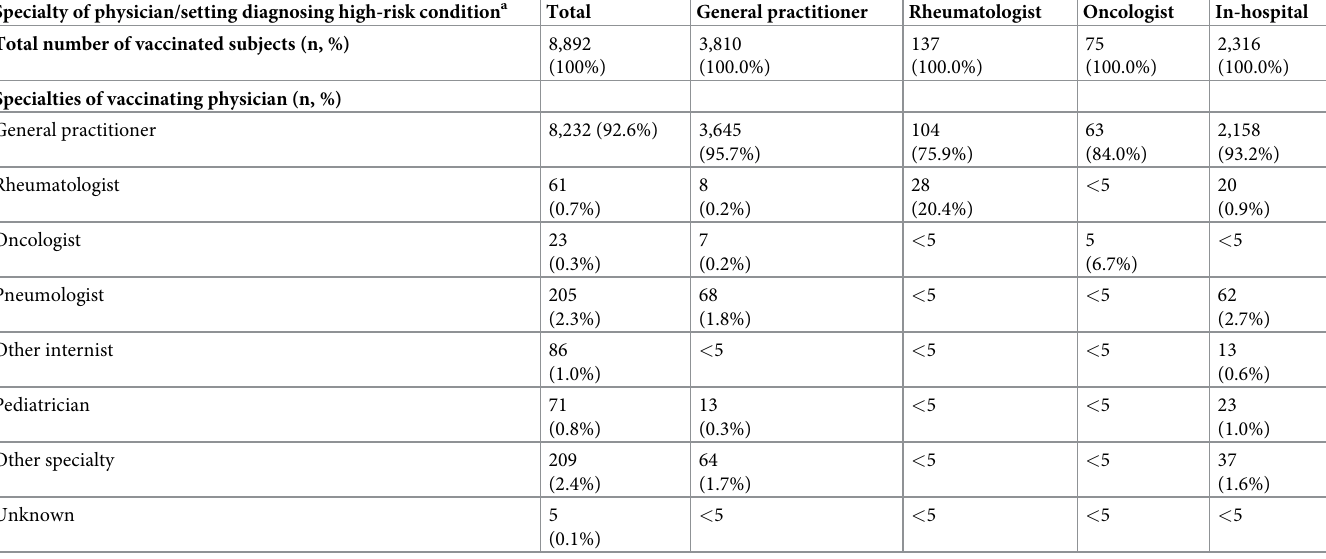
a Information for subgroups of less than 5 patients are not displayed due to data protection